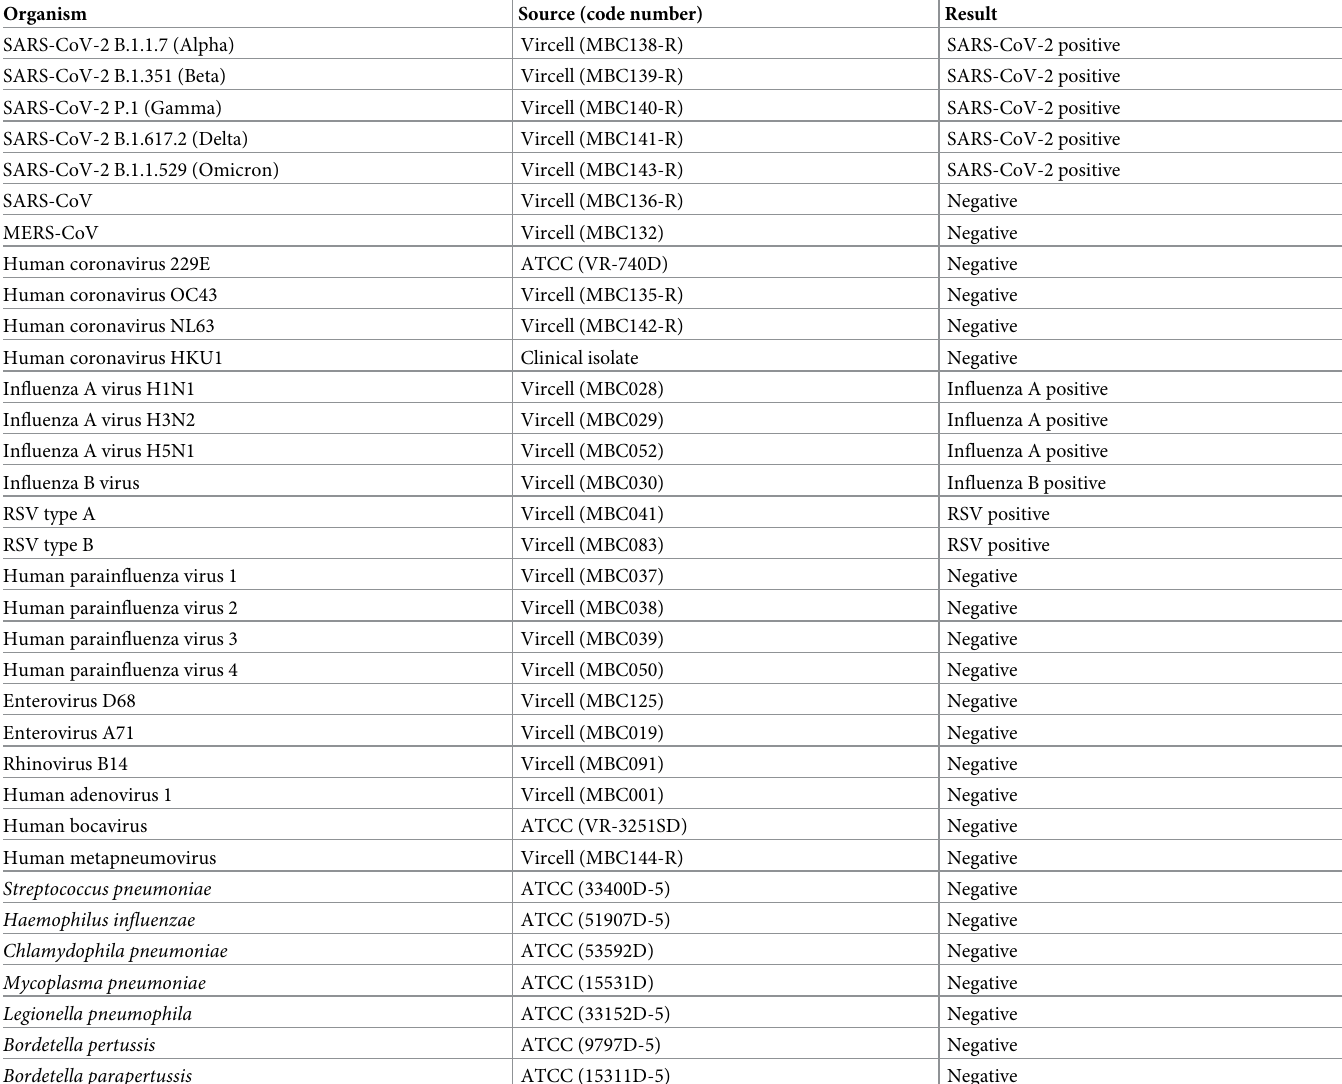
Table 2. Analytical specificity evaluation results of the Kaira assay.